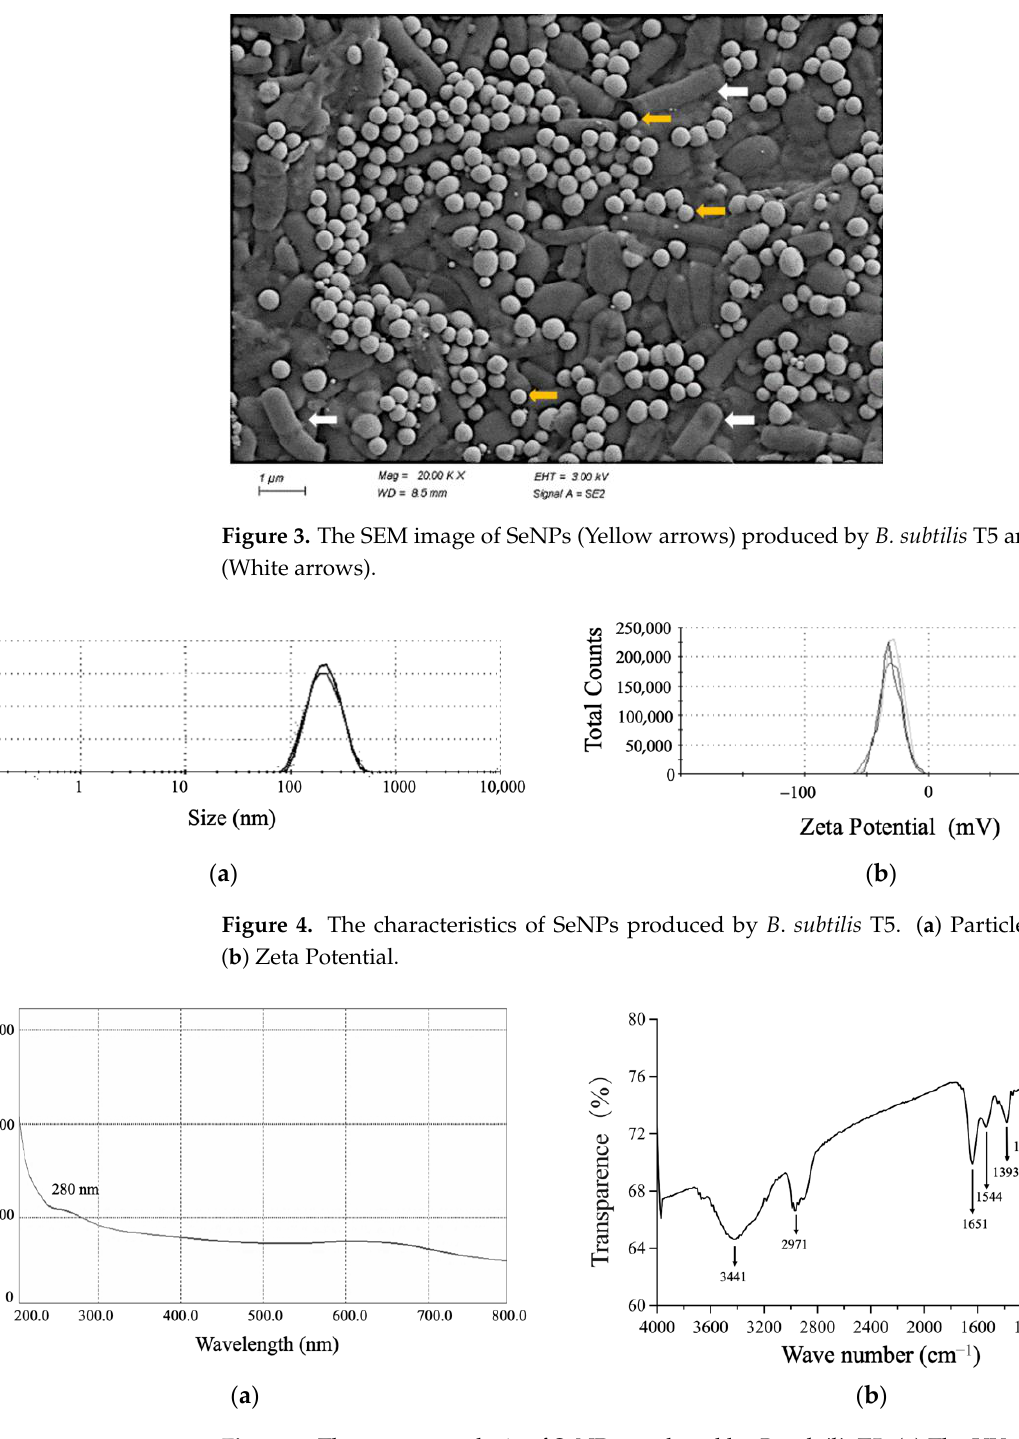
Figure 5. The spectra analysis of SeNPs produced by B . subtilis T5. ( a ) The UV-vis spectra; ( b ) The FTIR spectra.